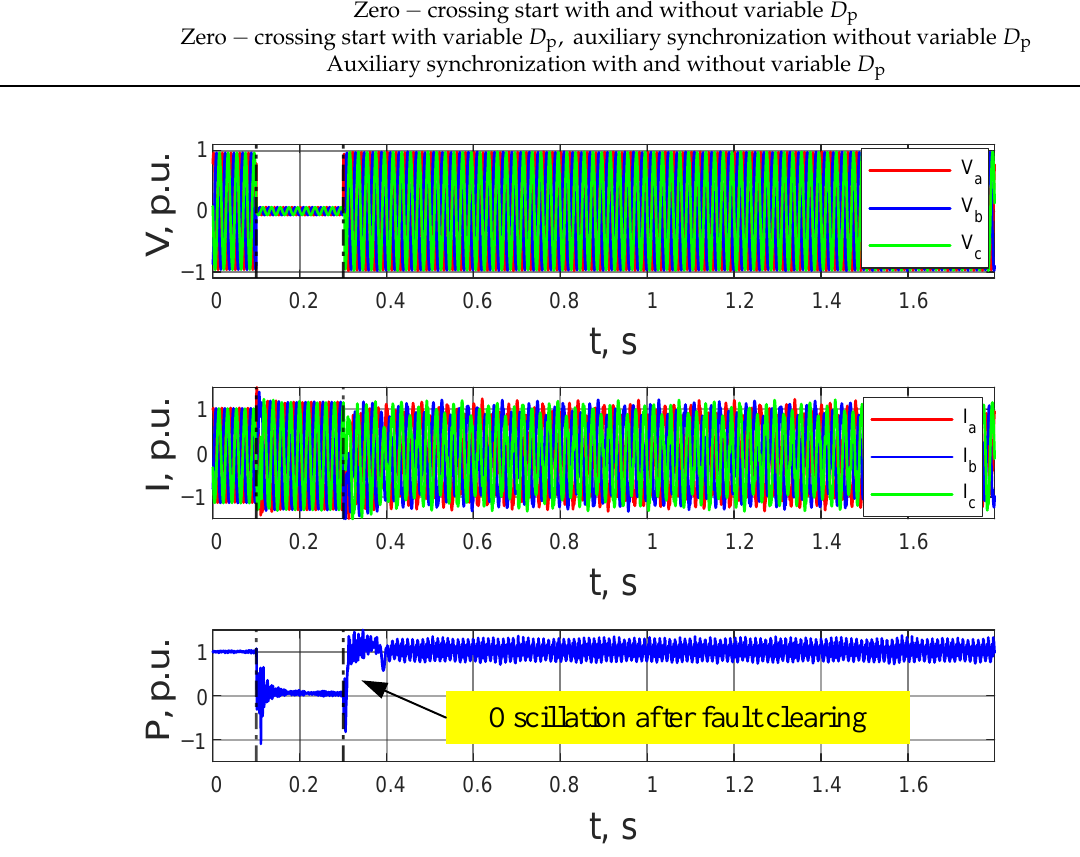
Figure 19. Zero-crossing start with and without variable droop factor 𝐷 p . The usage of a variable 𝐷 p (magenta curve) leads to a faster power recovery after the fault clearing. Figure 19a shows the current curve for a zero-crossing strategy with a non-variable 𝐷 p . The current amplitude decreases to near zero after the fault is cleared, and then slowly increases. Figure 19b shows the current curve for a zero-crossing strategy with variable 𝐷 p . The current amplitude increases rapidly after the fault clearing. The same result can be verified in the active power curve in Figure 19c, where the variable 𝐷 p strategy (magenta curve) recovers more quickly than the non-variable 𝐷 p strategy (black curve) during the post-fault period, which provides more active power to the grid. With no variable droop factor 𝐷 p , the time of active power rises to 0.7 p.u. in 450 ms from the time of the fault clearing, while with variable droop factor 𝐷 p , the time of active power rises to 0.7 p.u. in 80 ms.